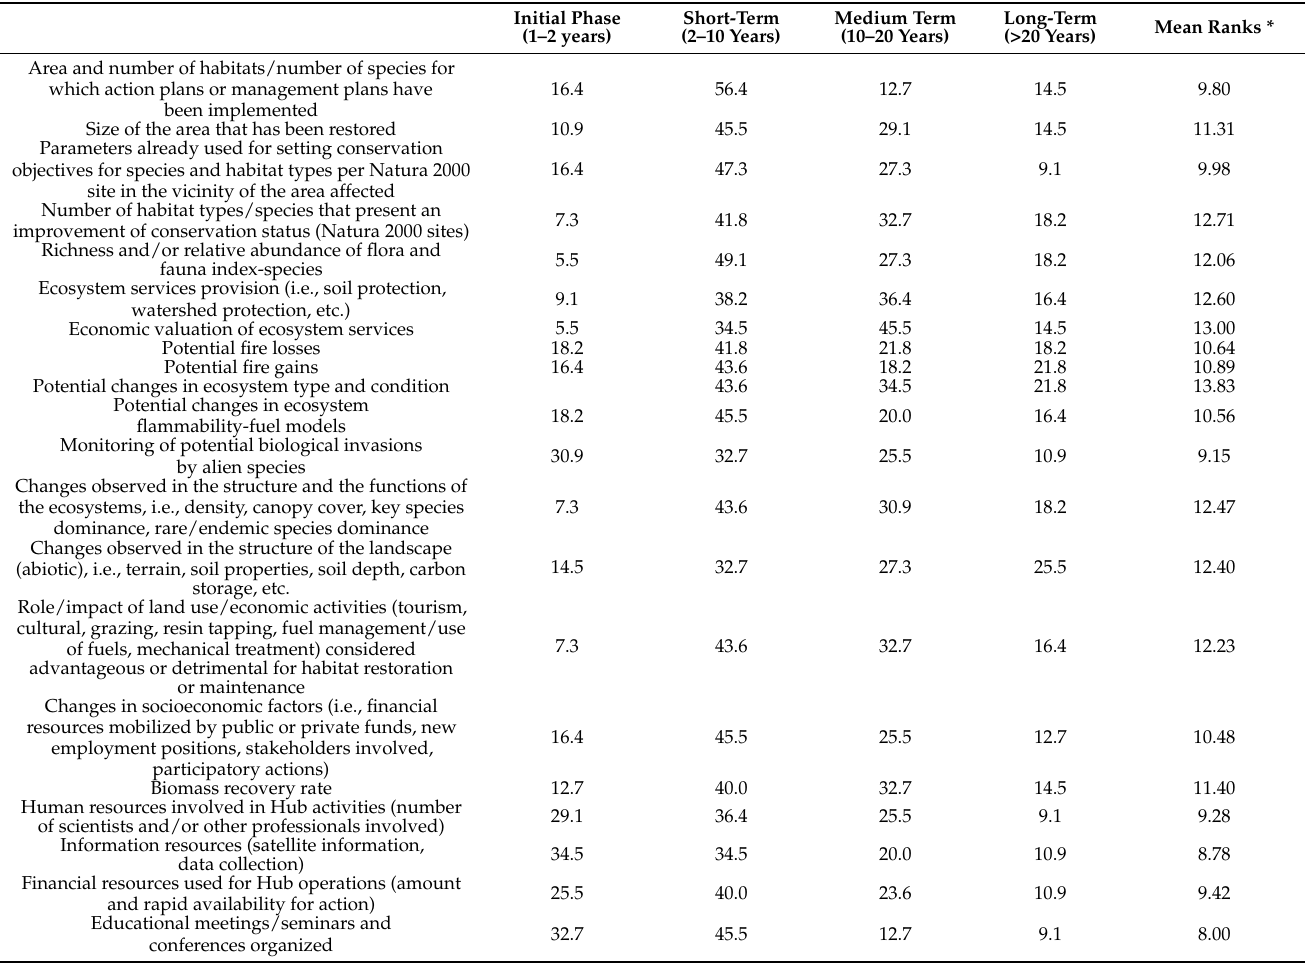
Table 9. Percentage units and differences among respondents’ views on the selection of